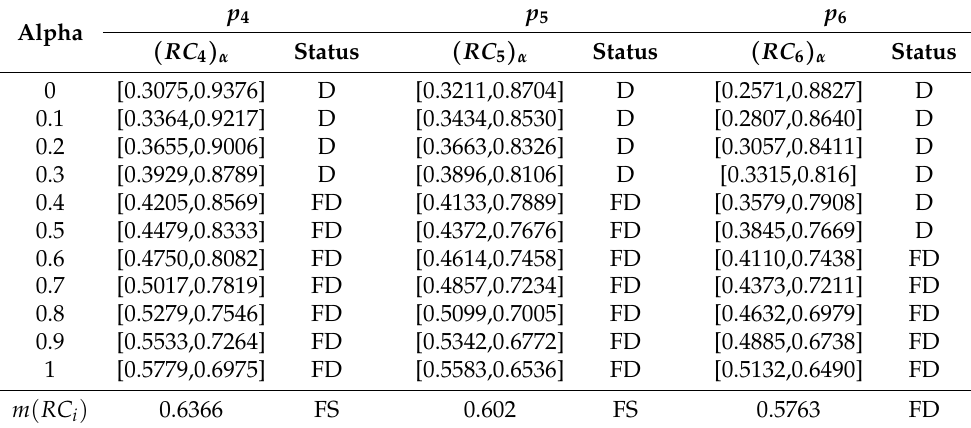
Table 15. Sensitivity analysis results of RC i and related status results-continued.